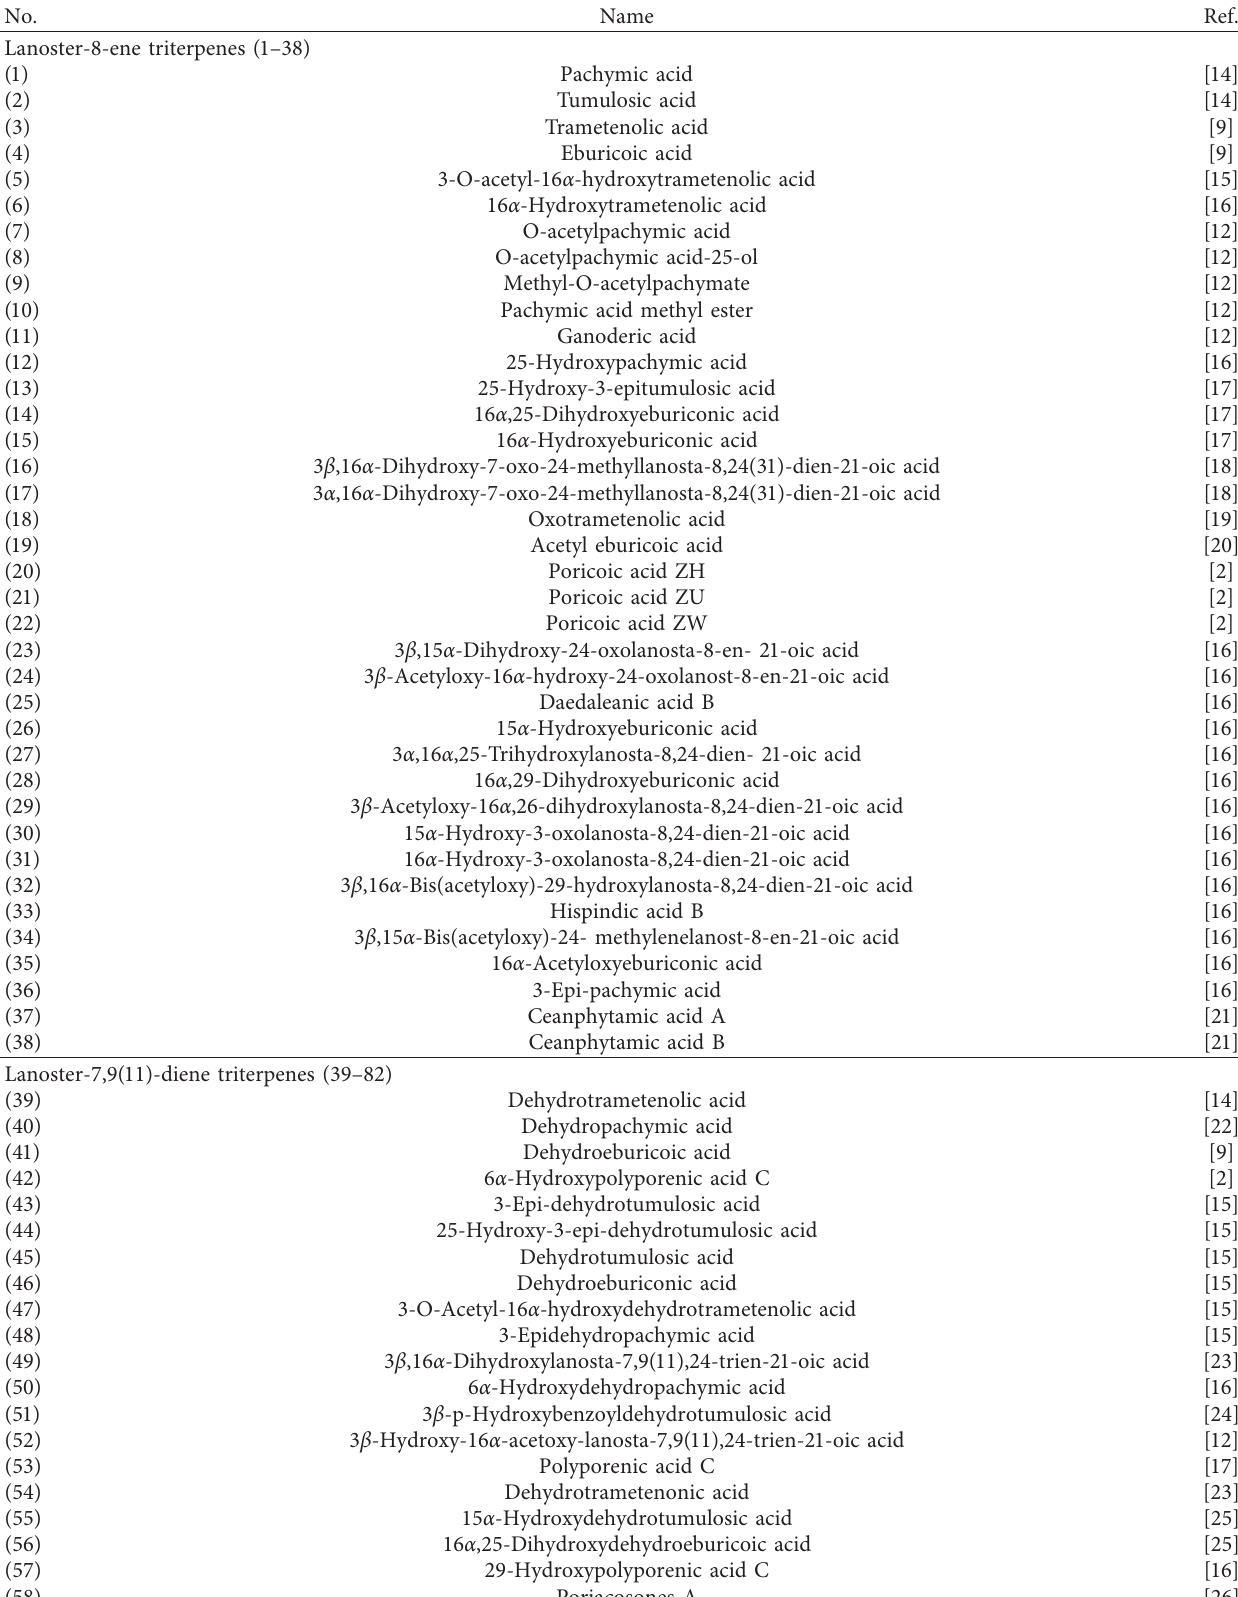
Table 1: Terpenoids isolated from Poria .